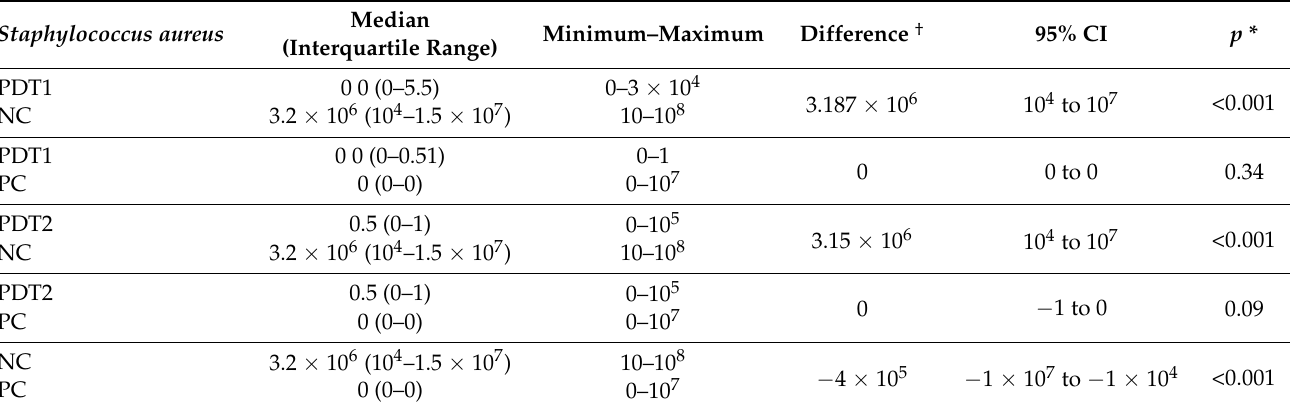
Table 1. Difference in the number of Staphylococcus aureus CFUs between groups (NC, PC, PDT1,